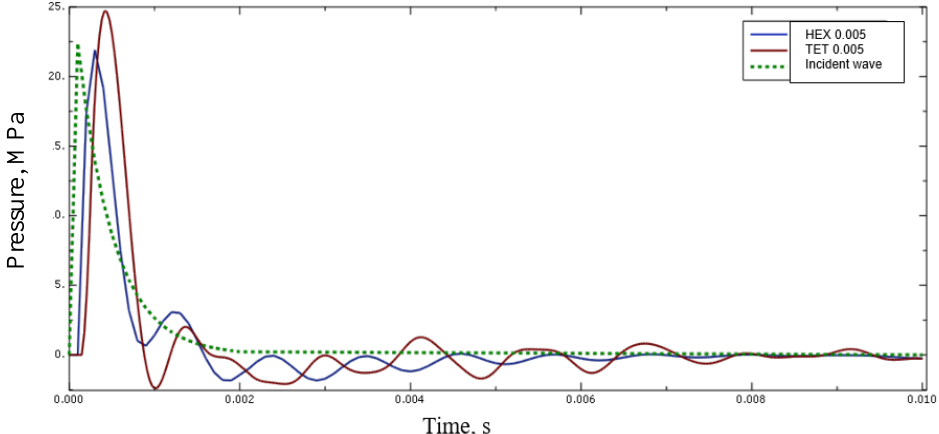
Figure 12. Pressure values on the front of a shock wave at the measuring point for acoustic elements with a size of 0.005 m (TET — tetragonal elements, HEX — hexagonal elements).